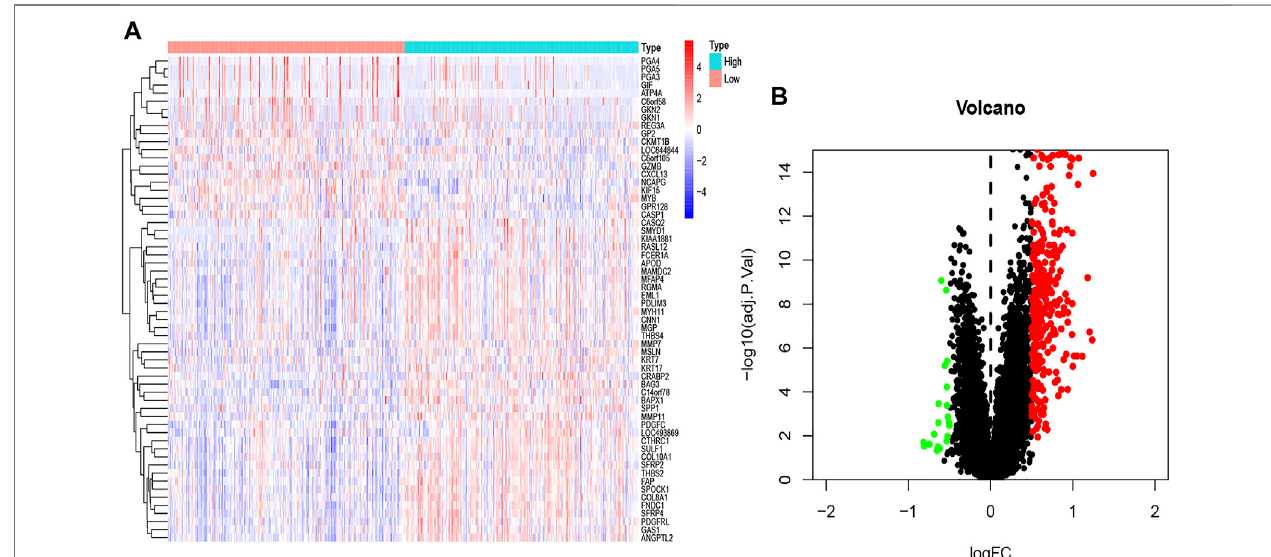
FIGURE 5 | The heatmap (A) and volcano plot (B) of mRNA expression changes based on ITGB5 in GC samples from the GEO database.